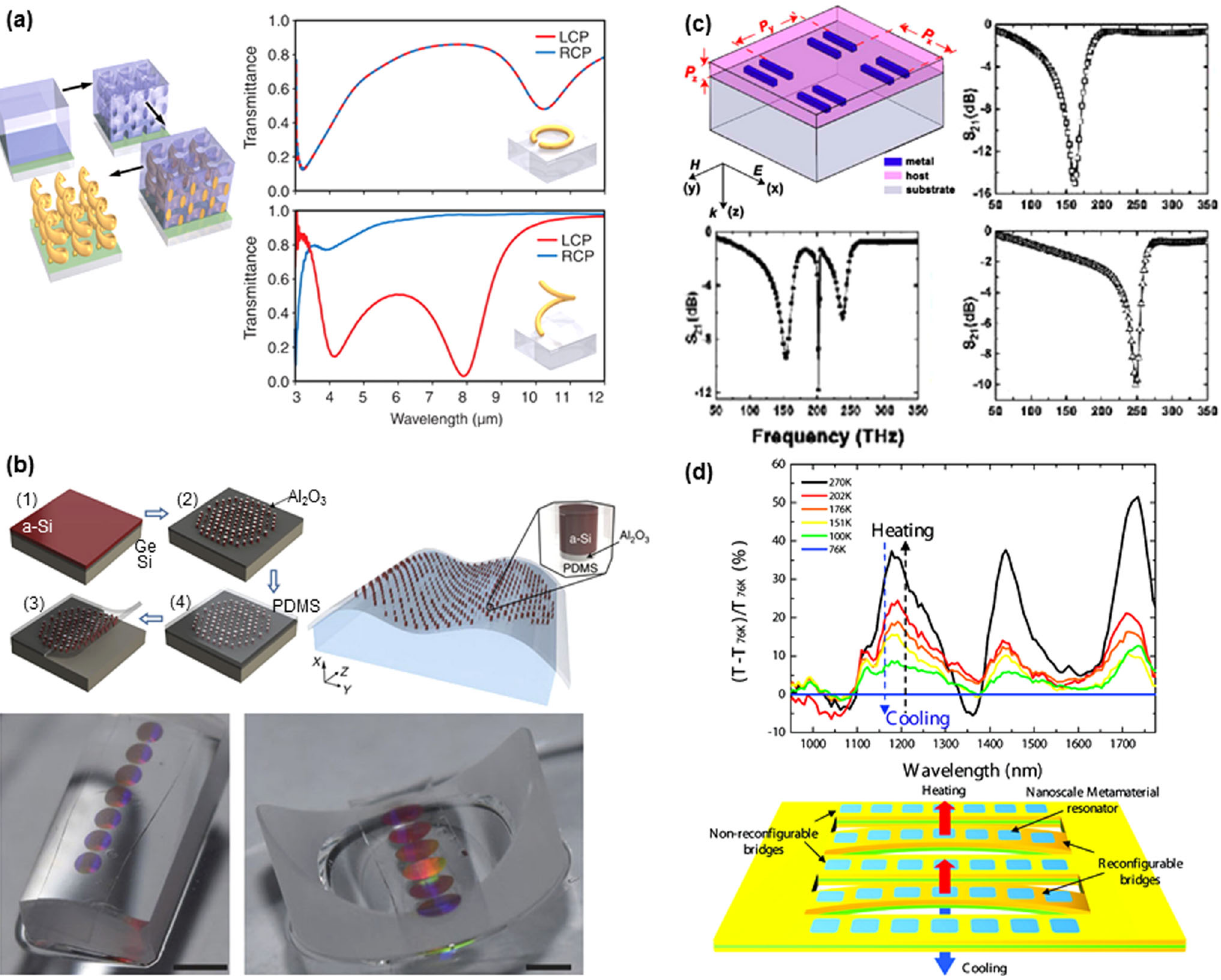
Fig. 6 Photonic metamaterials. a Fabrication process to form an array of air helices through 3D direct laser writing of polymer, gold plating, and removal of the polymer (left). The right shows 2 by 2 mm unit cells with 2 mm helix pitch used in the calculations and normal incidence transmittance spectra for light impinging from the air side (RCP and LCP: right and left-handed circular polarization of the incident light). Right part demonstrates that the transformation from 2D to 3D structure leads to the selection on the polarization of light propagating through it. Adapted with permission from ref. 65. b Amorphous silicon nano-posts on a thin layer of aluminum oxide embedded in a low-index fl exible substrate as a metasurface can conform to surfaces of arbitrary shape. Either a convex (lower left) or a concave (lower right) glass cylinder coated with a metasurface can behave as an aspherical lens to focus light to a point. Adapted with permission from ref. 66. c In a metamaterial composed of metallic double bars, transmission spectrum only shows one resonance mode, when the double bars are symmetric in length (both are 120 or 200 nm, middle). Asymmetric design in double bars (120 nm for one and 200 nm for the other one) results in a new resonance mode due the coupling of LSPR. Reprinted with permission from ref. 69. d A thermally tunable metamaterial structure consisting of alternating recon fi gurable and non-recon fi gurable bimaterial bridges shows temperature tunable transmission normalized to a reference temperature of 76 K. Bilayered beam in recon fi gurable bridges will bend in response to temperature changes, whereas no bending for a symmetric layer layout in non-recon fi gurable bridges (right). Reprinted with permission from ref.